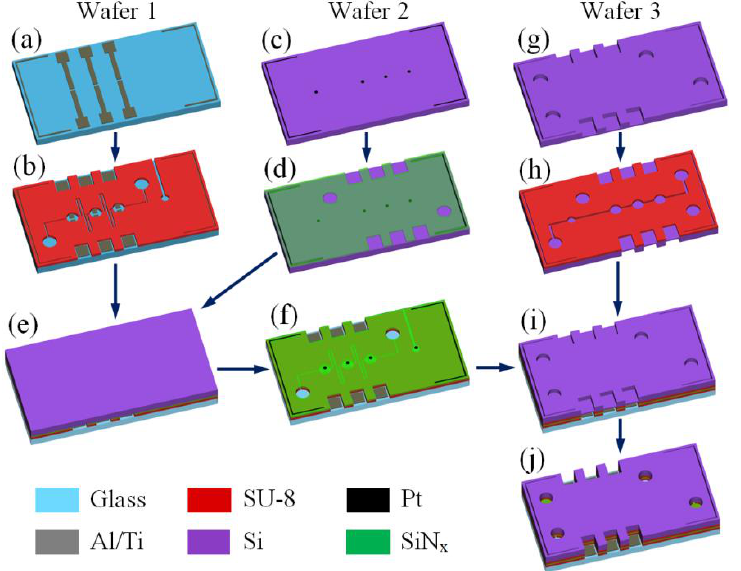
Figure 4. Fabrication procedure of the pump: ( a ) patterning of the Al/Ti electrodes on the glass wafer; ( b ) formation of the channels for the electrolyte in the SU-8 layer; ( c ) patterning of Pt disks on the Si wafer; ( d ) deposition and patterning of the SiN x film; ( e ) bonding of SiN x to SU-8; ( f ) complete plasma etching of the Si wafer; ( g ) partial plasma etching of the holes in the Si wafer; ( h ) formation of the channels for the pumped liquid in the SU-8 layer on the opposite side; ( i ) bonding of SU-8 to SiN x ; ( j ) final etching of the holes.